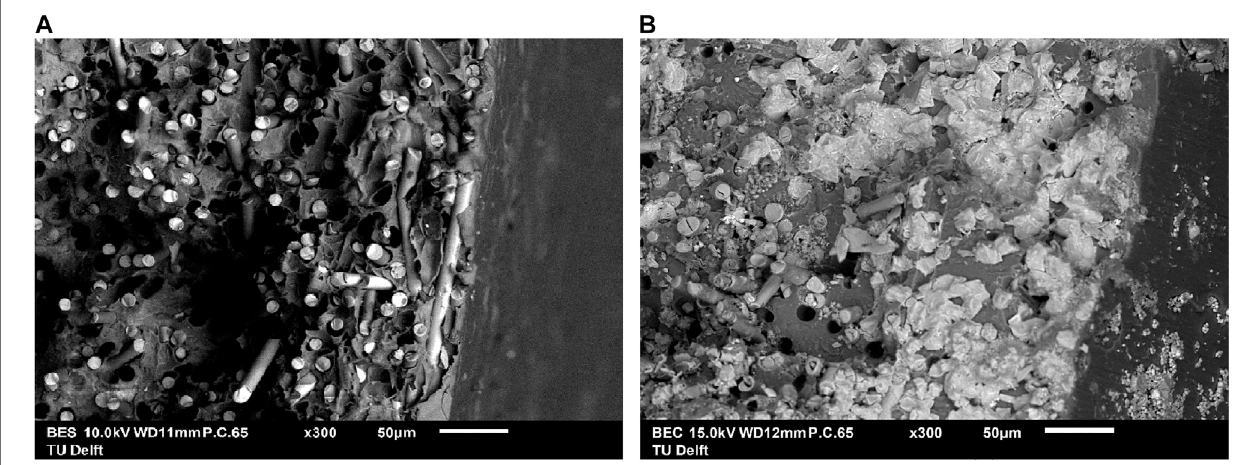
FIGURE 7 | SEM images at × 300 magni fi cation of the fracture surface of (A) unaged PPS-40%gf, and (B) PPS-40%gf exposed to 30 wt% KOH at 90 ° C for 61 days. The glass fi bers suffered severely.